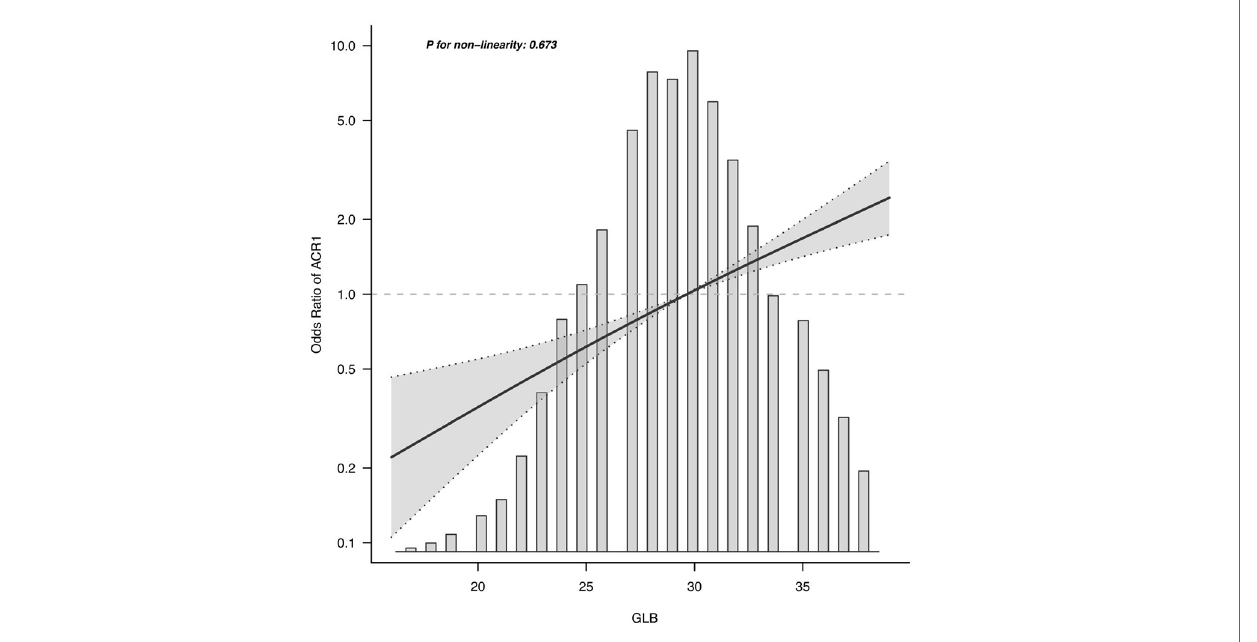
FIGURE 2 | Curve fi tting of serum globulin and diabetic